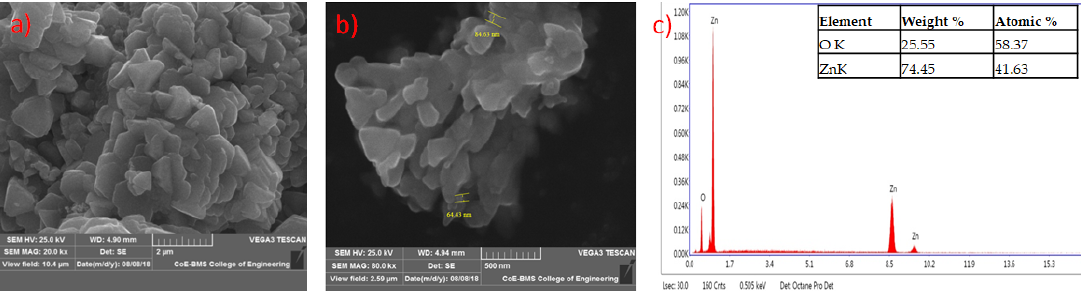
Figure 8. SEM image of zinc oxide nanoparticles synthesized from Trichoderma spp. co-culture of (PGTA) at lower ( a ) and higher ( b ) magnification; ( c ) represents energy-dispersive X-ray spectroscopy (EDAX) analysis.